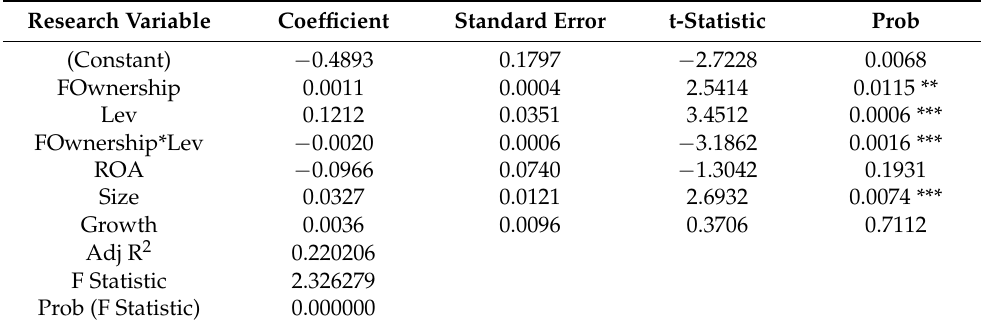
Table 3. Family Shareholding and Earnings